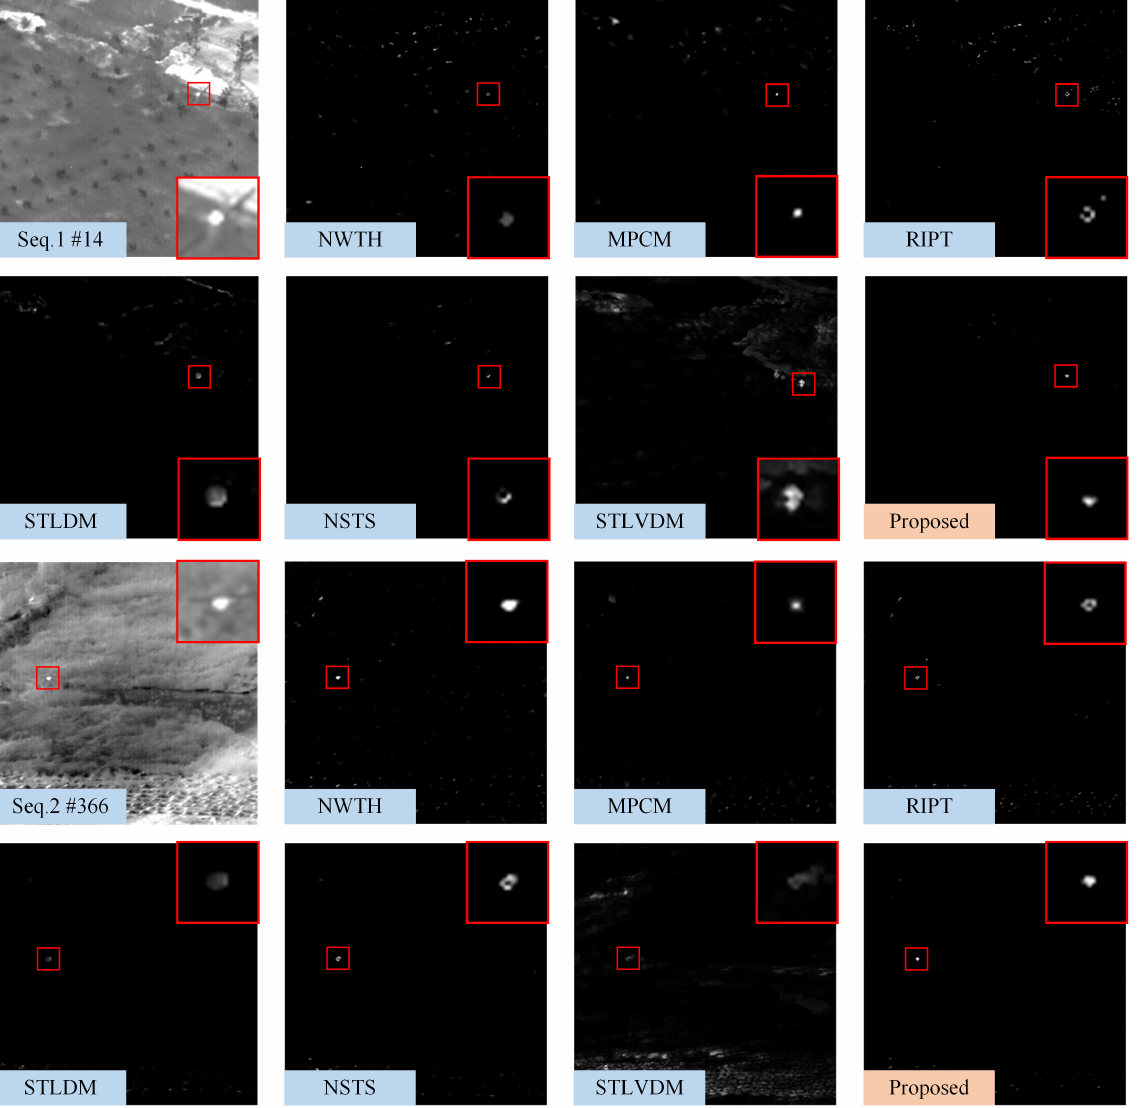
Figure 8. The saliency maps obtained by different methods on 14th frame in Seq.1 and 366th frame in Seq.2. For the sake of clarity, the target regions are marked with red boxes, and a close-up version is shown on each